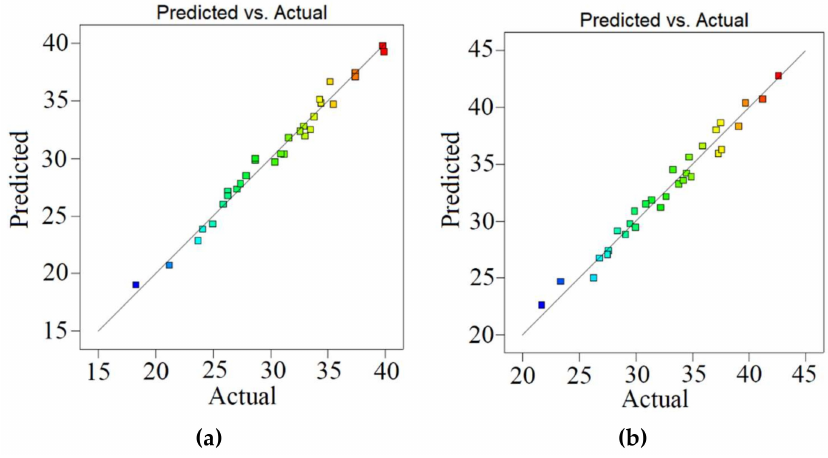
Figure 3. Model prediction versus experimental values for the removal of SMX ( a ) and OFX ( b ) with diatom. Table 4. Statistical analysis results for response parameters in RSM.